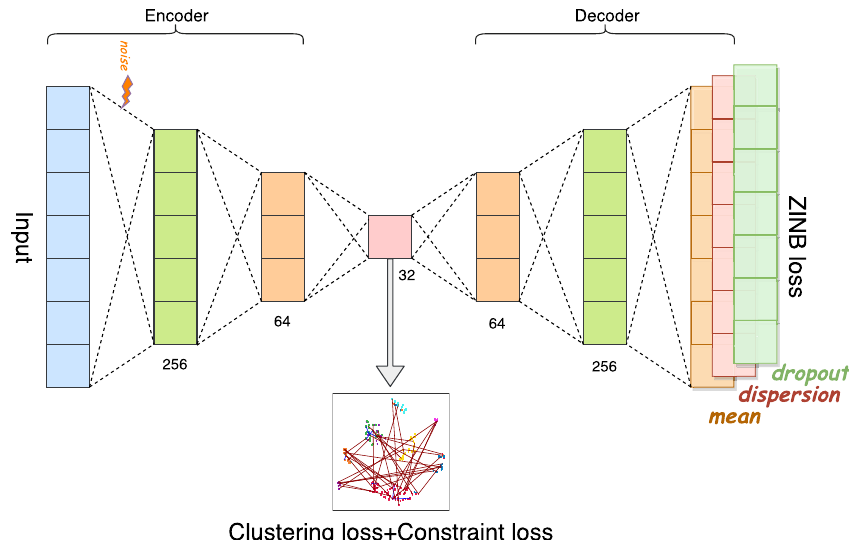
Fig. 1 Network architecture of scDCC. The autoencoder is a fully connected neural network. The number below each layer denotes the size of that layer.